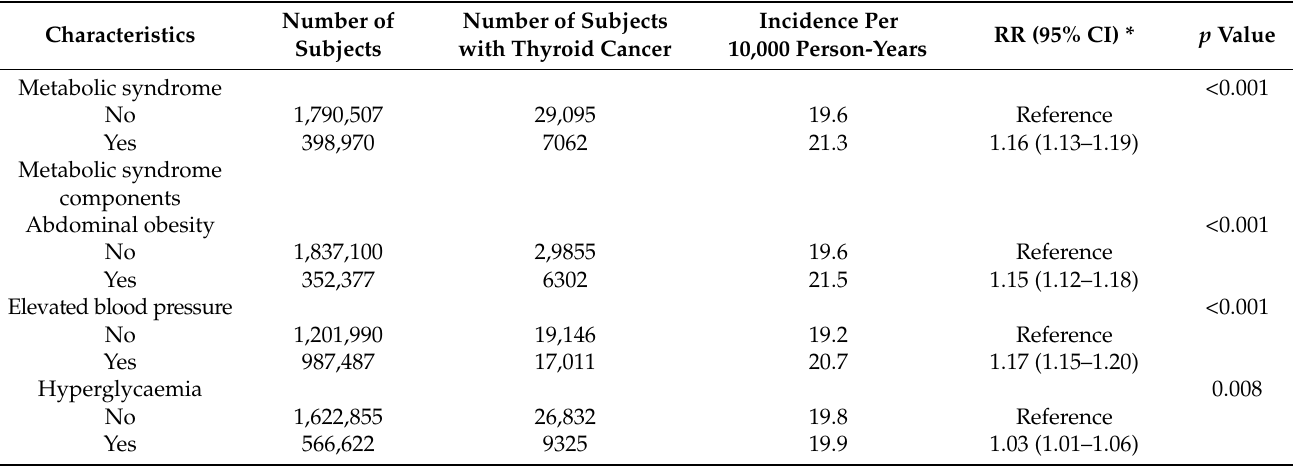
Table 3. Association of metabolic syndrome or its components with the risk of thyroid cancer in female